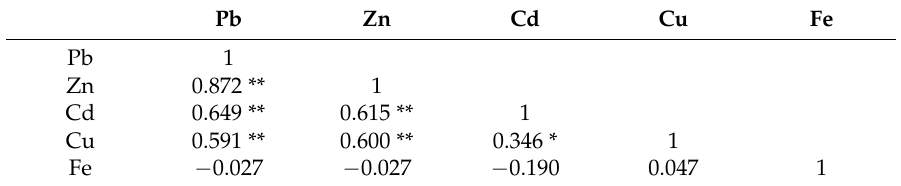
Table 3. Metal-to-metal correlation coefficient matrix for metals in sediment